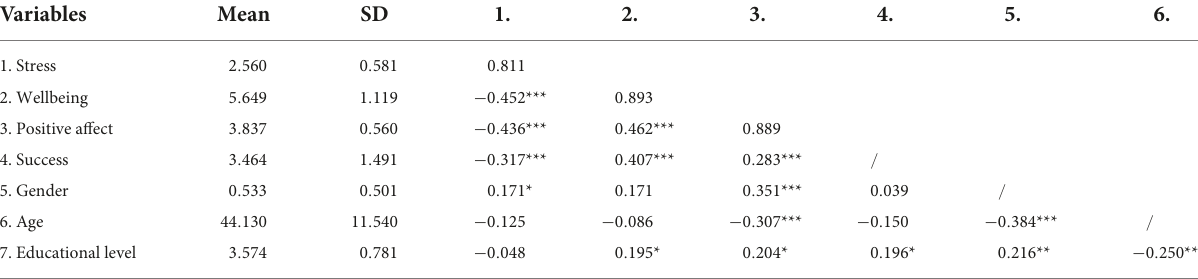
TABLE 1 Descriptive statistics, correlations and square roots of the average variance explained.